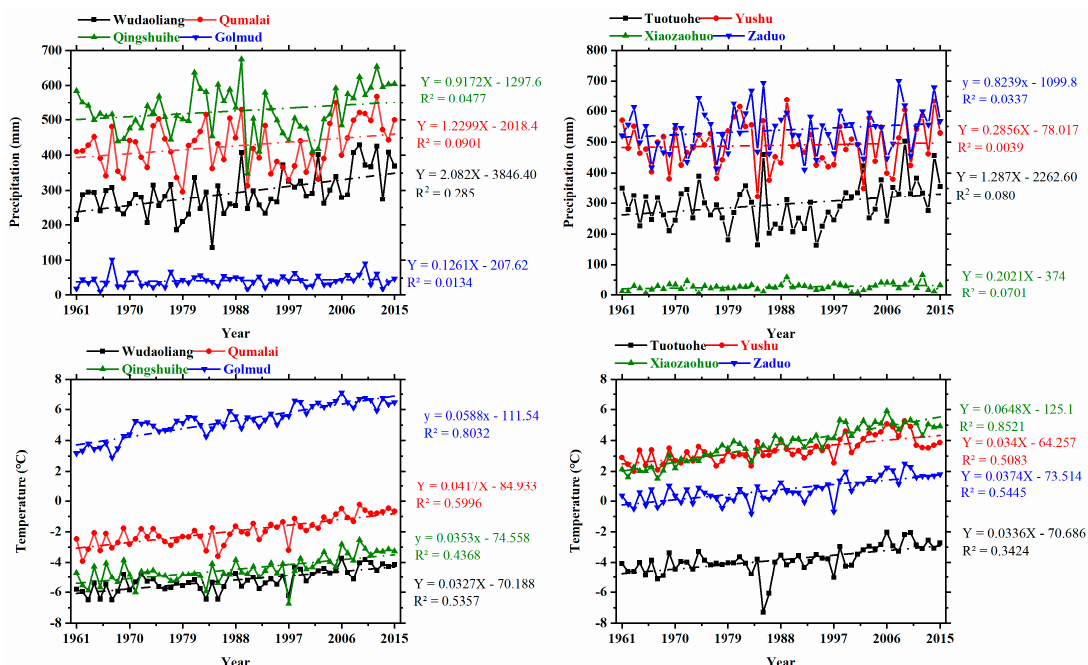
Figure 3. Precipitation and temperature trends for each climatic station in HWYZ during 1961–2015. Table 3. Linear trends in precipitation and temperature and modified Mann–Kendall statistics (Z) during 1961–2015. Bold values show statistically significant trends at a 0.05 significant level.